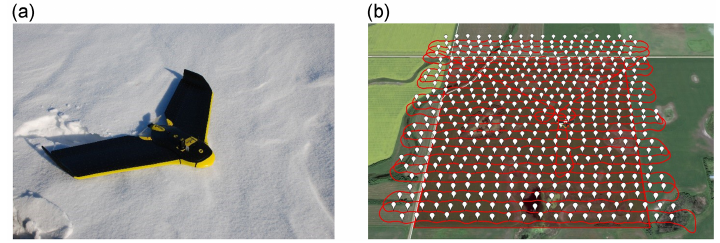
Figure 2. (a) A senseFly Ebee RTK; (b) a typical flight over the prairie site, where red lines represent the flight path of UAV and the white placemarks represent photo locations.